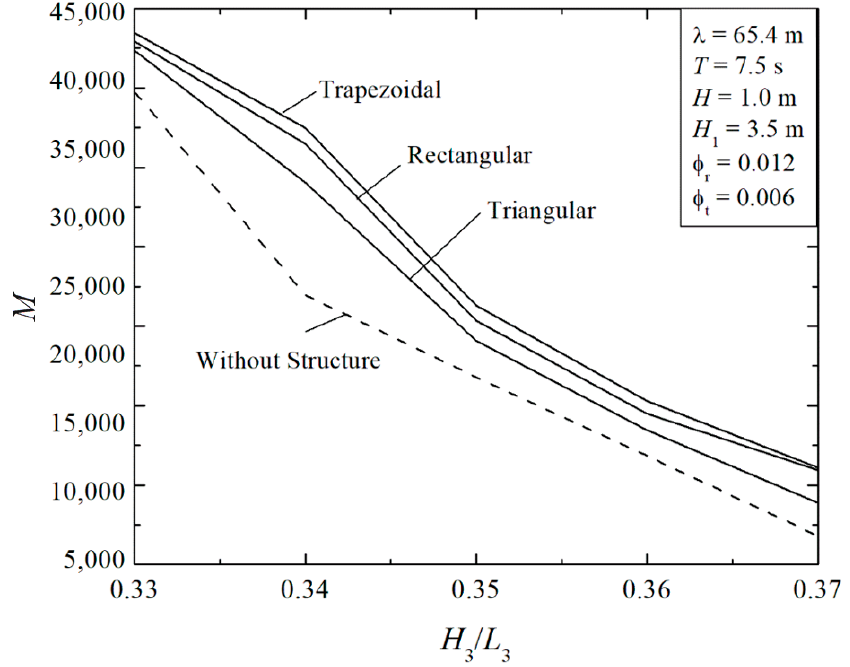
Figure 12. Comparison between the performance of the device without an obstacle studied in [25] with the device integrated with different geometric shapes of